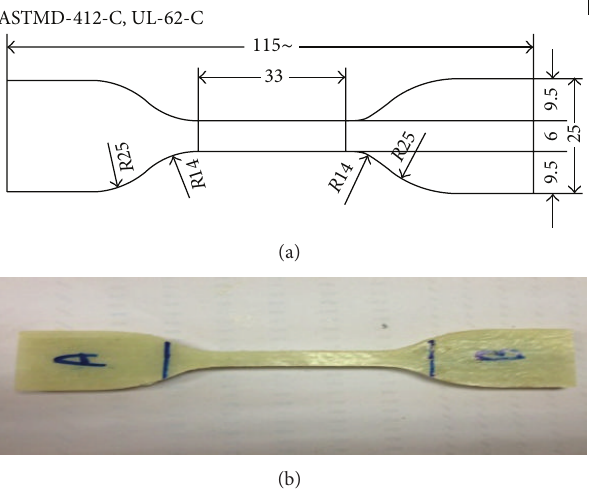
Figure 2: Testing dumbbell shape (a) ASTM D-412 type C and (b) hybrid GFRP.